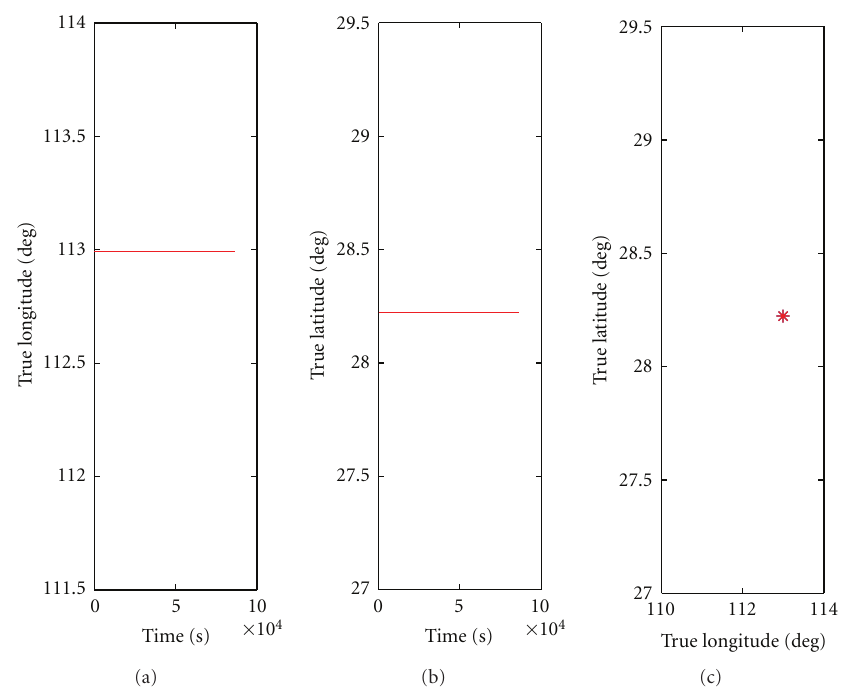
Figure 24: The trajectory of real data set B.